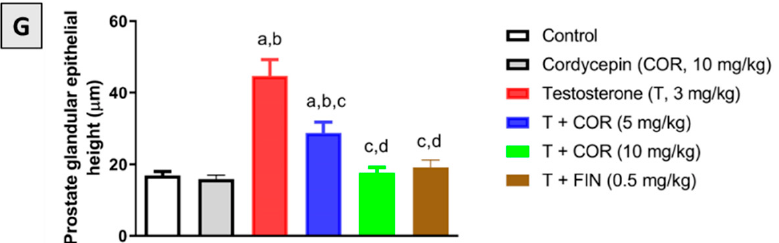
Figure 1. Effect of cordycepin on testosterone-induced pathological changes on prostate tissues: ( A ) control group and ( B ) cordycepin-alone group showing normal prostate tissue architecture; ( C ) testosterone-treated group (3 mg/kg) showing hyperplasia of prostatic acini; ( D ) cordycepin (5 mg/kg) + testosterone-treated group and ( E ) cordycepin (10 mg/kg) + testosterone-treated group showing moderate and high restoration of almost normal prostate histology, respectively; and ( F ) finasteride + testosterone group is without apparent acini hyperplasia. ( G ) Graphic presentation of prostate glandular epithelial height in the different treatment groups. Data are presented in the bar chart ( n = 6) as mean ± SD. COR = cordycepin, T = testosterone, FIN = finasteride. a, b, c, or d: statistically different ( p < 0.05) from control, cordycepin, testosterone or T + COR (5 mg/kg), respectively.